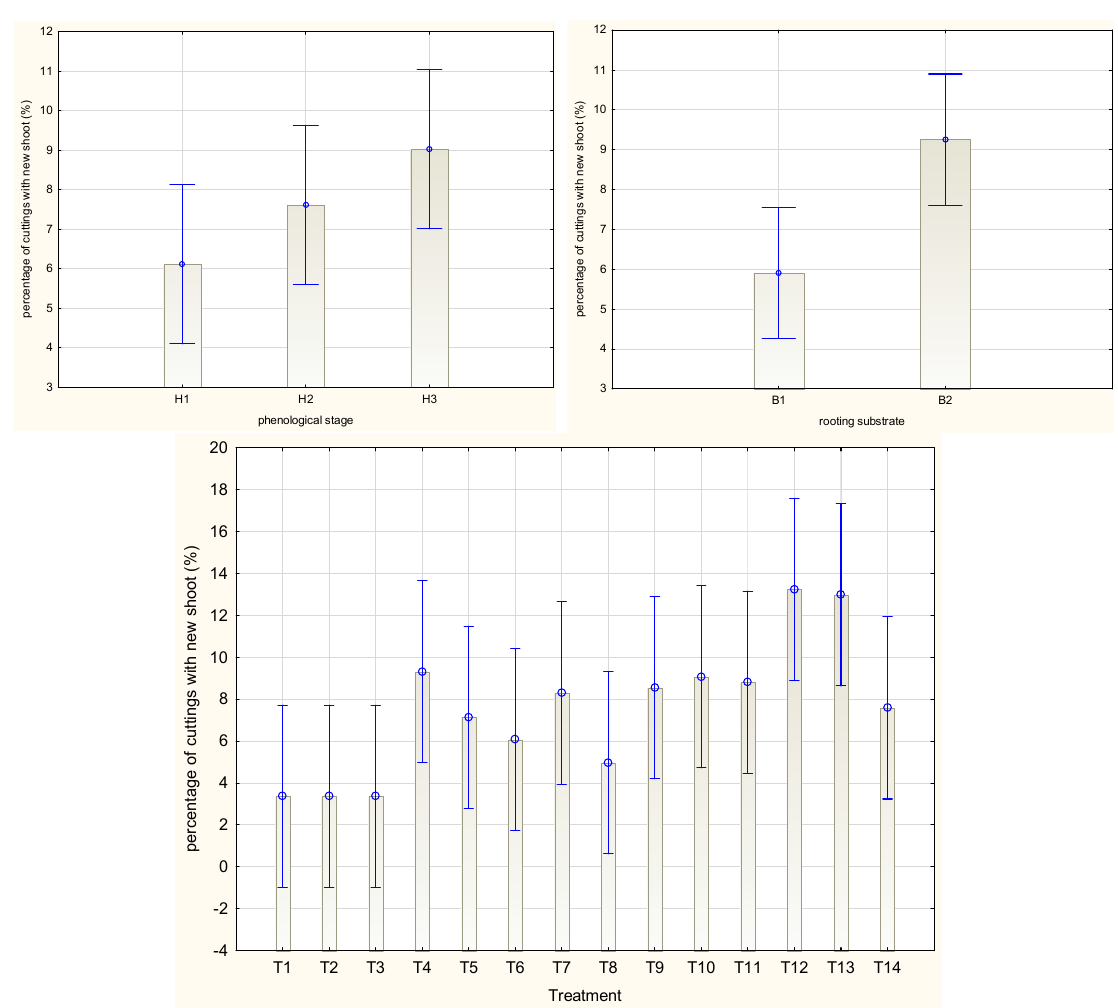
Figure 6. Percentage of cuttings with new shoot in Rosa ‘Hurdal’ cuttings prepared from three phenological stages (H1–H3) of shoots and rooted in two rooting substrates after treatment by rooting enhancers. B1—peat–perlite; B2—peat–sand; H1—flower buds closed (BBCH 54,504; flower buds still closed); H2—flowers opened (69,605; full flowering, at least 50% of flowers open); H3—immediately after petal shedding (69,629; end of flowering of second order stem: all petals fallen); and treated: T1—the control cuttings; T2—0.4% IBA (Ukorzeniacz A aqua ); T3—0.2% NAA (Ukorzeniacz B aqua ); T4, T5, T6, T7, T8, T9—Algae Extract: watering with 0.4% or 0.6% Bio Rhizotonic (10 mL) 1, 2, or 3 times (after planting and 10 and 20 days later); T10, T11, T12—Organic Preparation—watering with 0.1%, 0.2%, or 0.4% Root Juice™ (10 mL) after planting; T13, T14—Plant Extract—watering with 0.012% or 0.02% Bio Roots (10 mL) after planting. The degree of rooting on a 5-point scale: 1—only a callus, without formed roots; 2—at least one short root; 3—a few longer roots; 4—roots visibly developed, differentiated by the length; 5—strong roots starting to form a root ball, well developed. Vertical bars denote 95% confidence intervals for the mean of counts (one-way